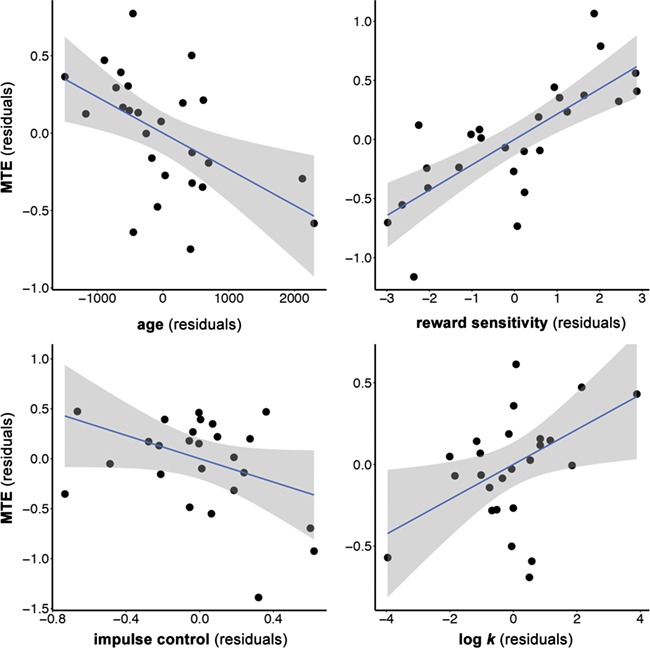
Partial residual plots from the vSTR linear regression model (Model 1 of Table 5), illustrating the relationships between MTE and key variables in Study 2.